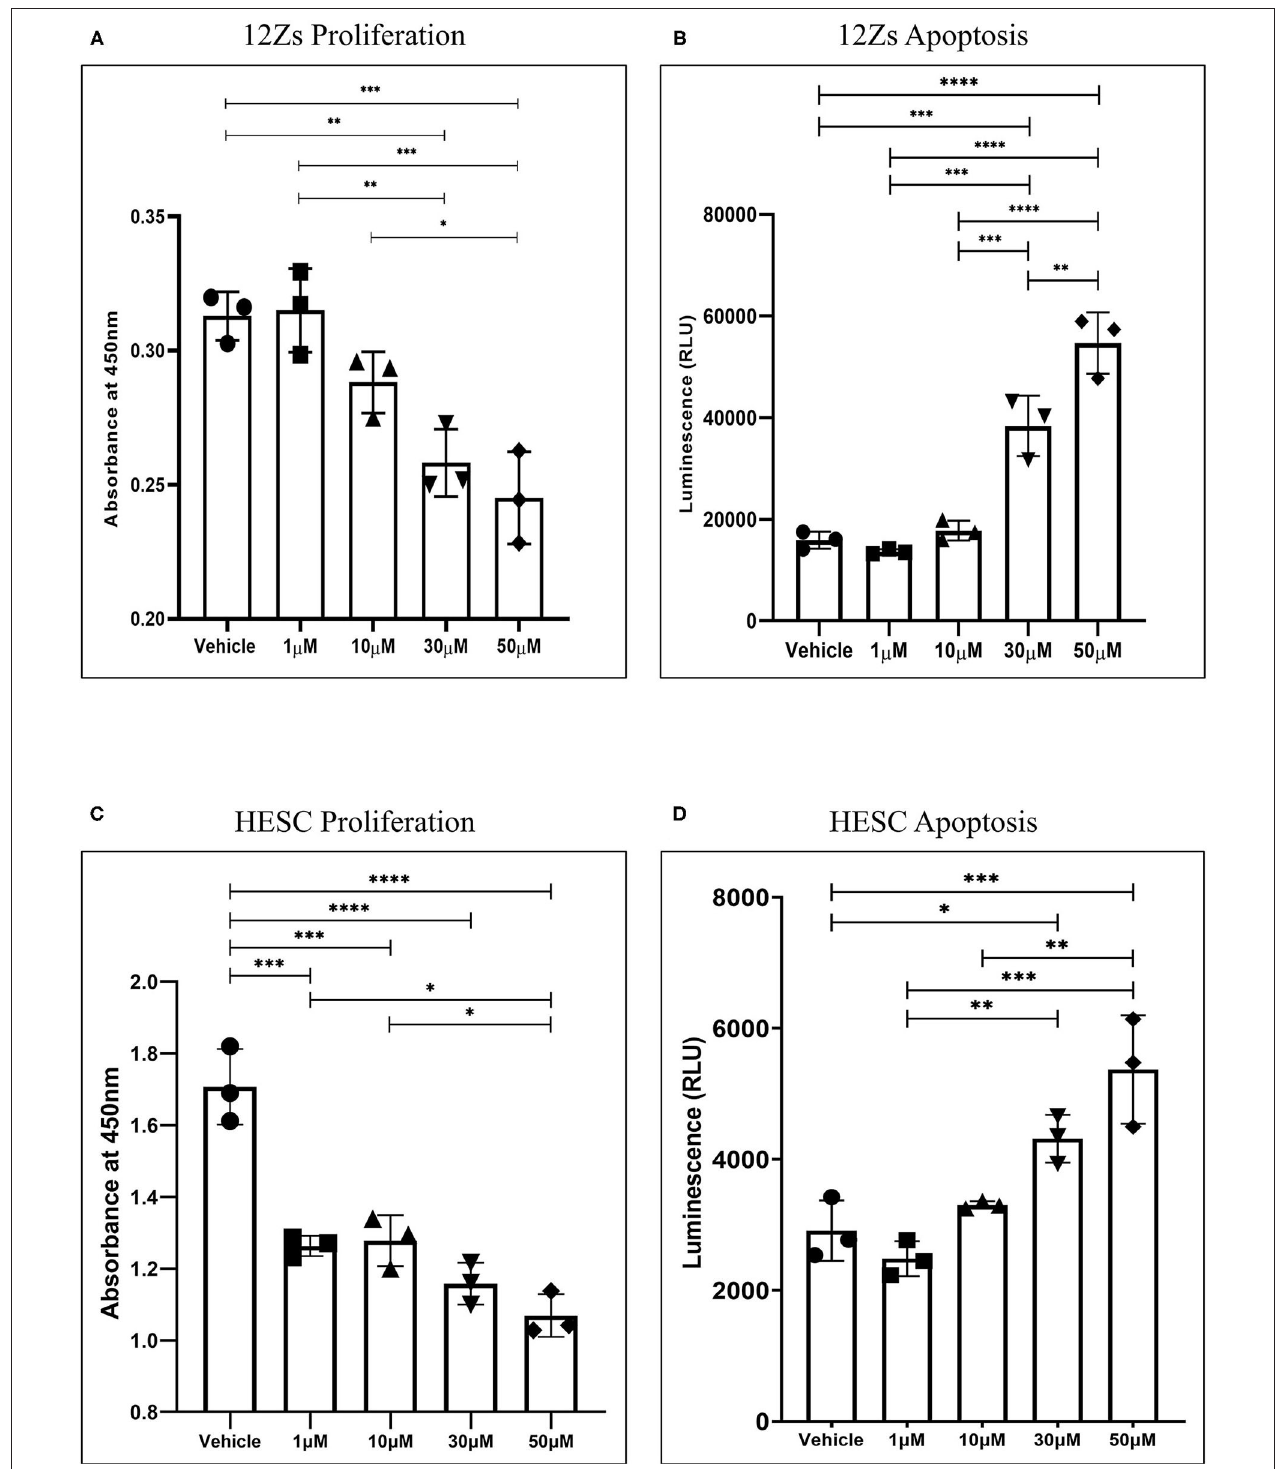
FIGURE 1 | Stimulation of CB1 and CB2 receptors in endometriotic epithelial cells (12Z) and endometrial stromal cells (HESC) attenuates proliferation by triggering apoptosis. (A) Treatment with various concentrations of WIN 55 leads to attenuation of proliferation in a dose-dependent manner. (B) Caspase 3/7 activity in the cell supernatant showed that WIN 55 exposure triggered apoptosis in 12Z cells. (C) WIN 55 exposure in HESC cells showed concentration-dependent reduction in proliferation with WIN 55 concentration as low as 1 µ M. (D) Apoptosis in HESC cells exposed to WIN 55 showed a similar dose-dependent increase in caspase 3/7 activity as observed in 12Z cells. Ordinary one-way ANOVA with Tukey post-hoc . * P < 0.05 ** P < 0.01 *** P < 0.001 **** P < 0.0001.